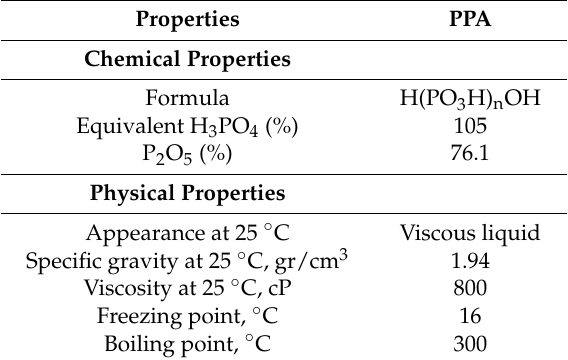
Table 3. The characteristic properties of PPA.